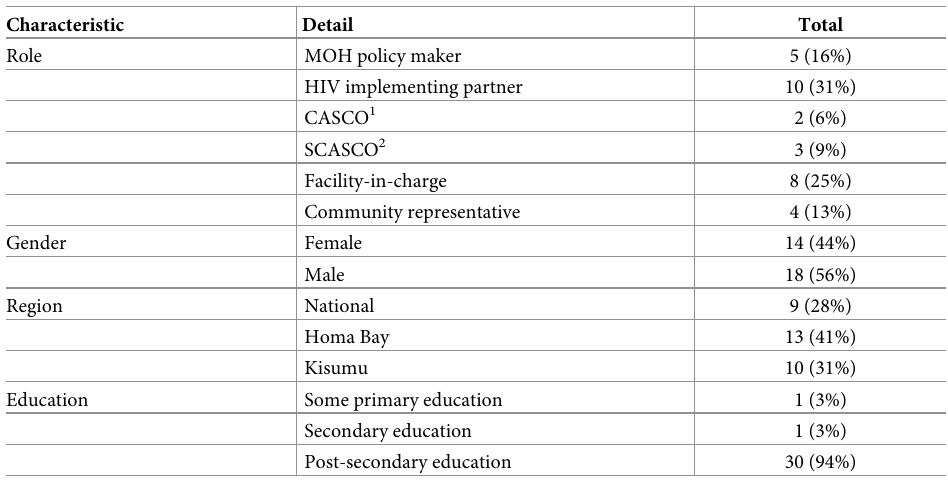
Table 1. Stakeholder